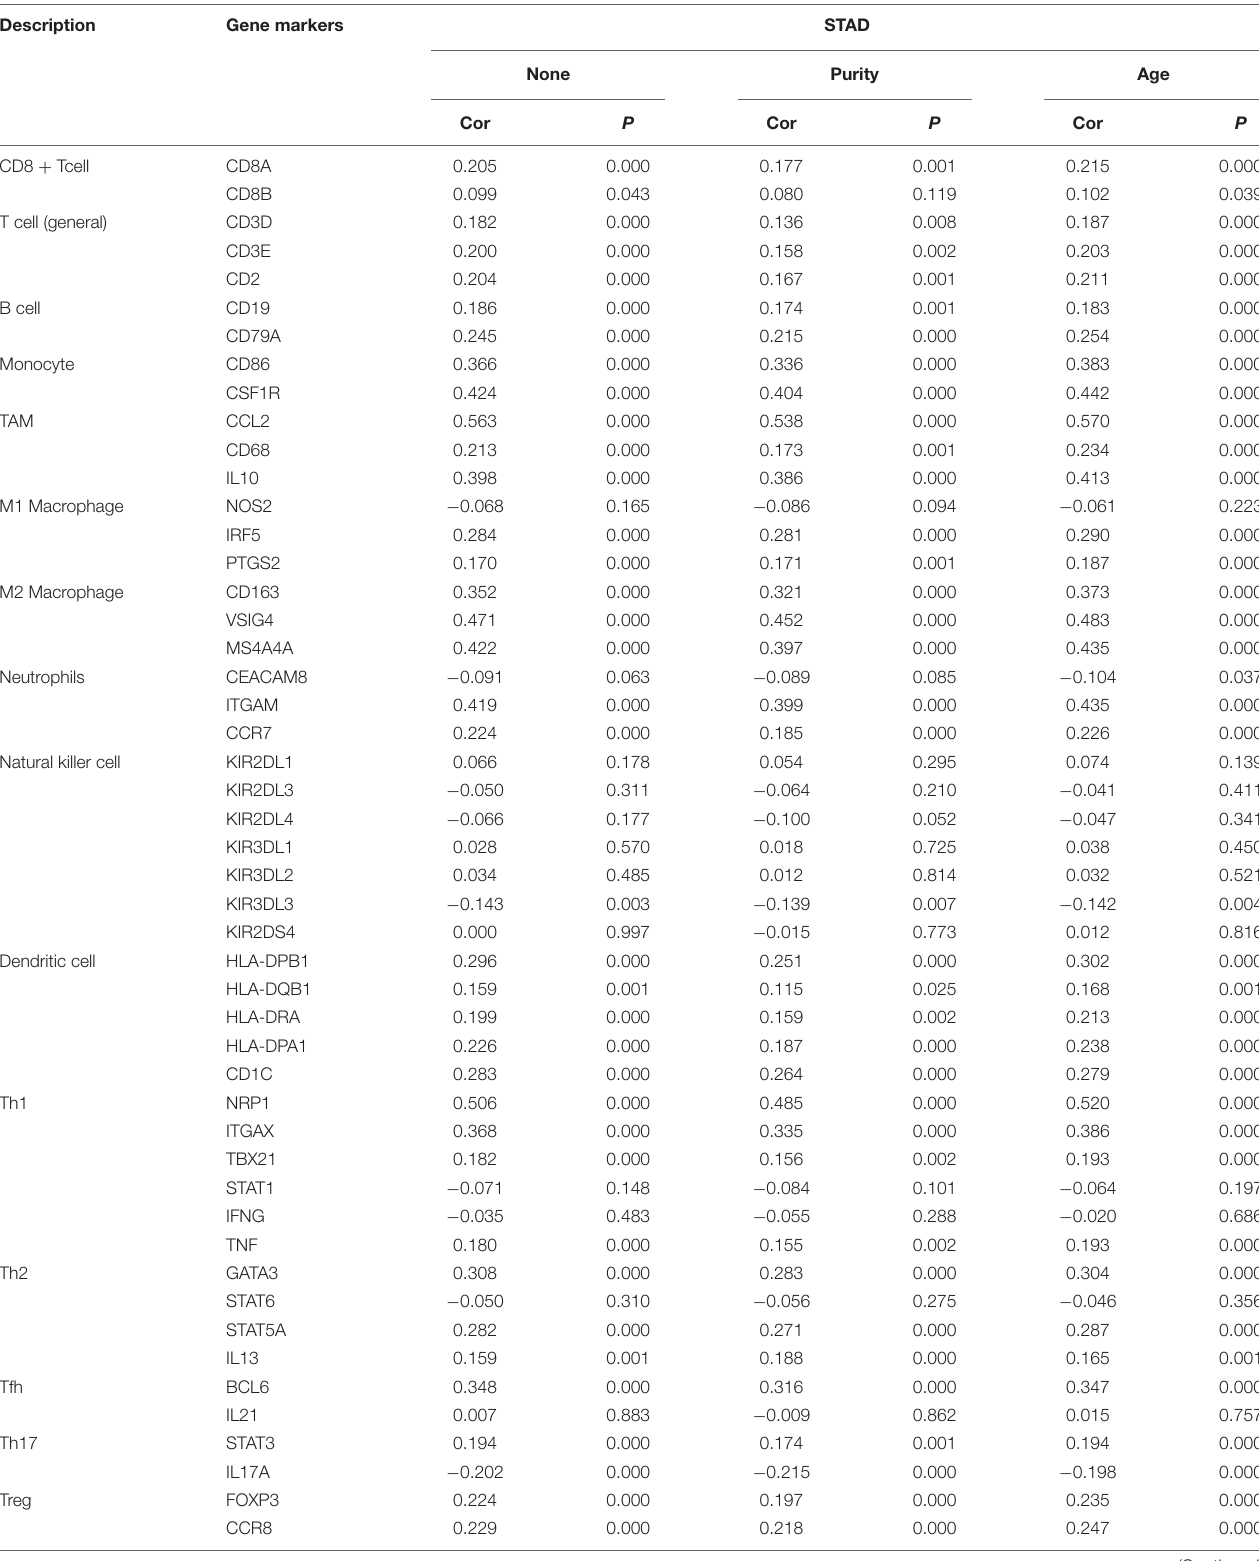
TABLE 2 | Correlation analysis between PCOLCE and relate genes and markers of immune cells in TIMER. Description Gene markers